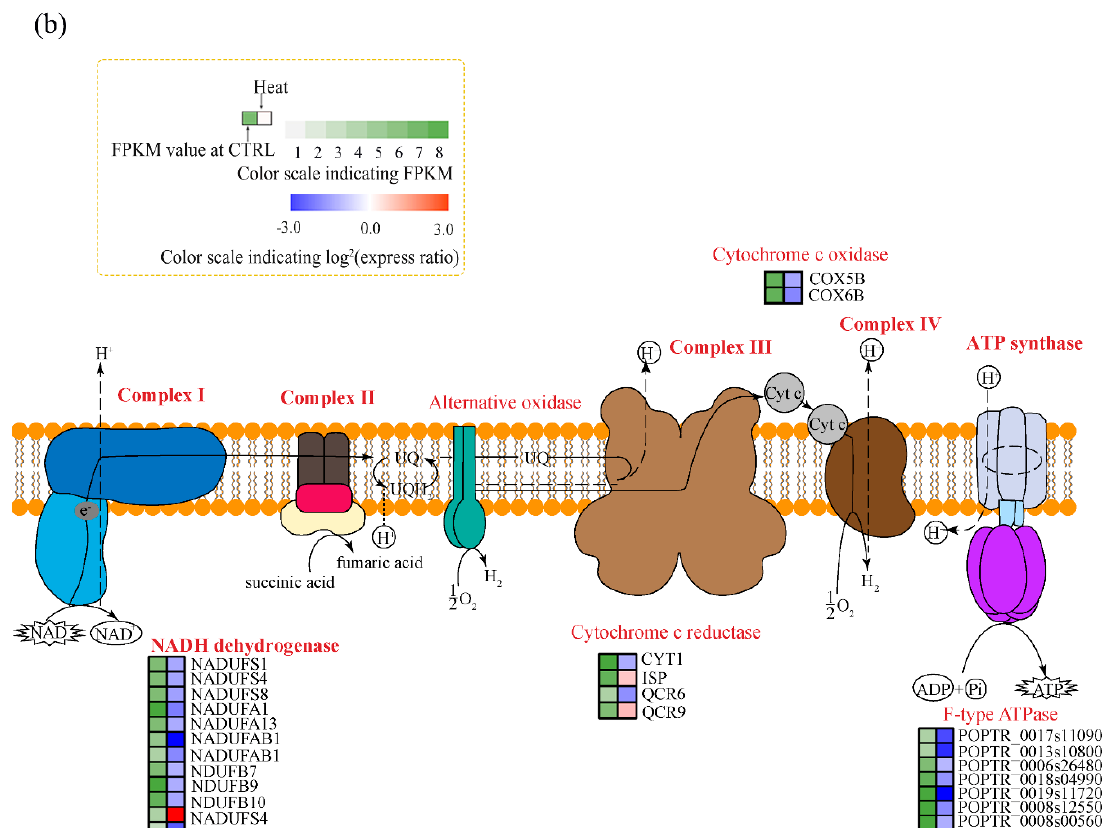
Figure 4. Changes in the expression of genes related to photosynthesis and oxidative phosphorylation underheatstress. ( a )Pathwaydiagramofthelightreactionsofphotosynthesis. LHCI / II,light-harvesting complex I / II; PS I / II, photosystem I / II; PQ, plastoquinone; Cyt b6, cytochrome b6f complex; PC, plastocyanin; Chl, chlorophyll; Fdx, ferredoxin. ( b ) Pathway diagram of oxidative phosphorylation. NAD, Nicotinamide adenine dinucleotide; UQ, ubiquinone; Cyt c, cytochrome; ADP, adenosine diphosphate; ATP, adenosine triphosphate. Colors at right indicate the log 2 expression ratio [log 2 (heat / control_ mean)], and at left the fragments per transcript kilobase per million fragments mapped (FPKM) value of the control. (Levels 1–8, FPKM values of 0–10, 10–20, 20–40, 40–80, 80–160, 160–320, 320–640, and 640 + ,